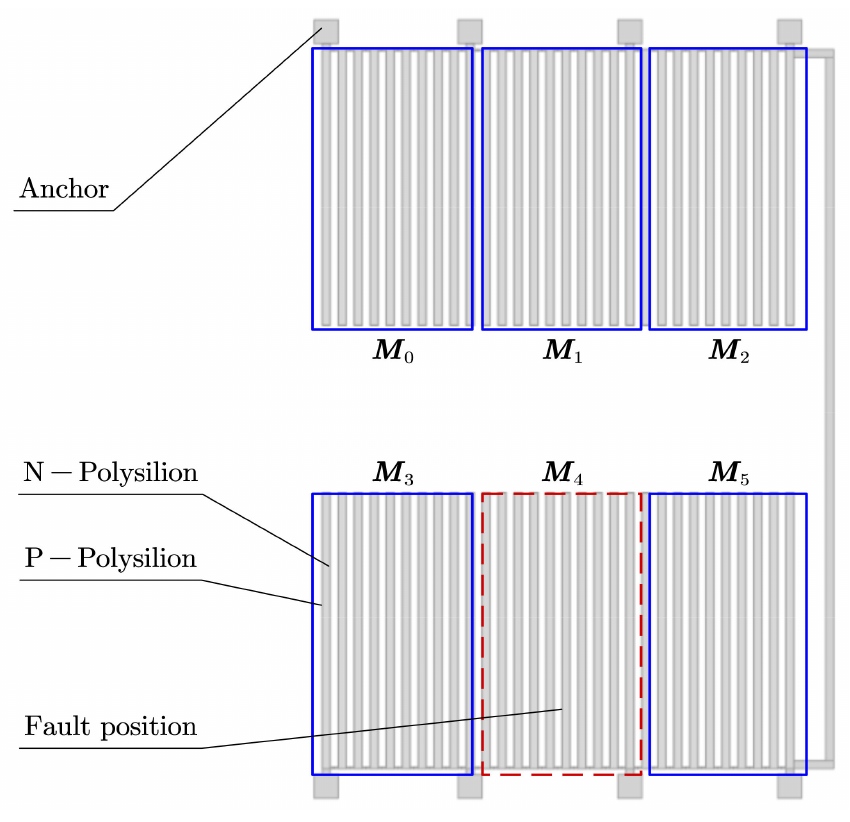
Figure 8. M modules of thermopile (M =